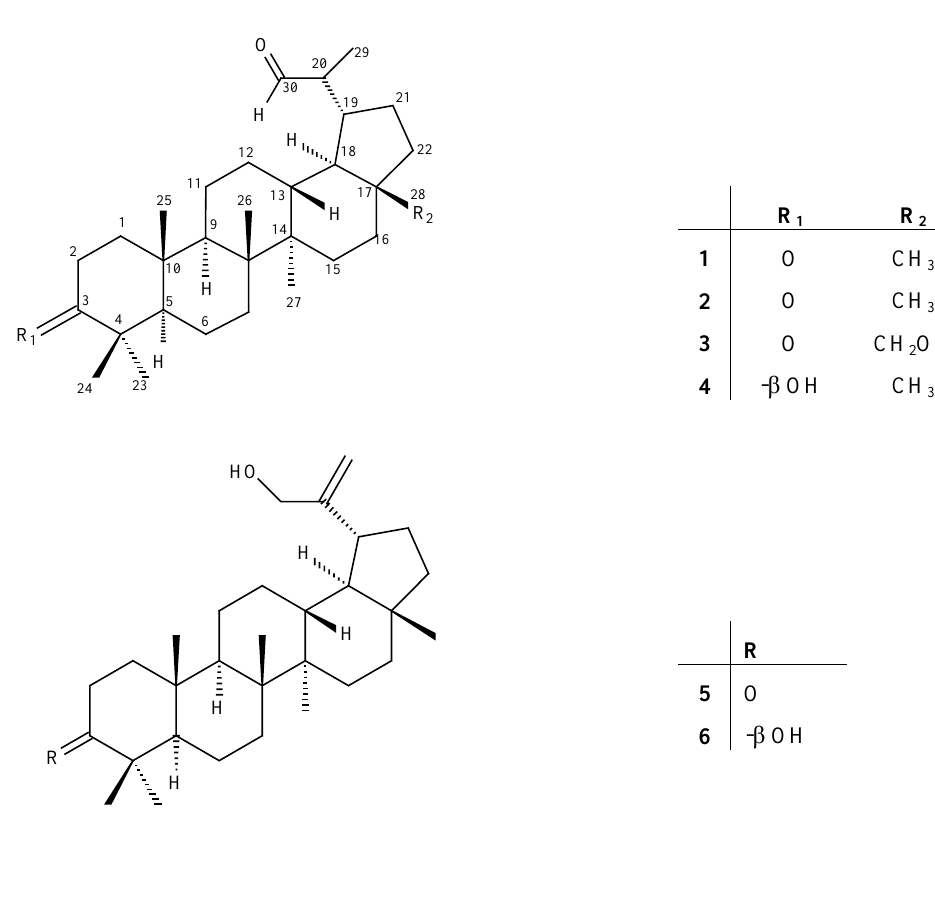
Figure 1 . Isolated lupane triterpenes from A. mellifera